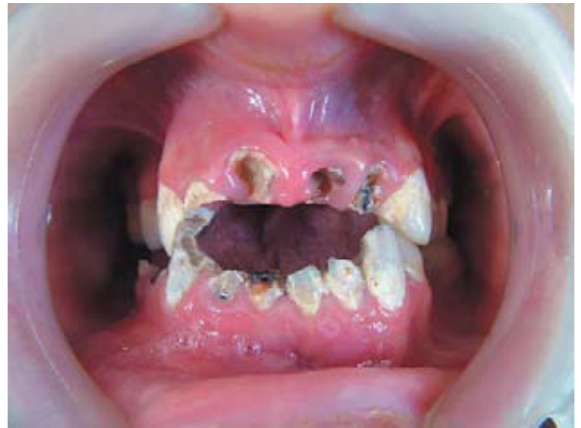
Figure 1- Preoperative intraoral view of teeth